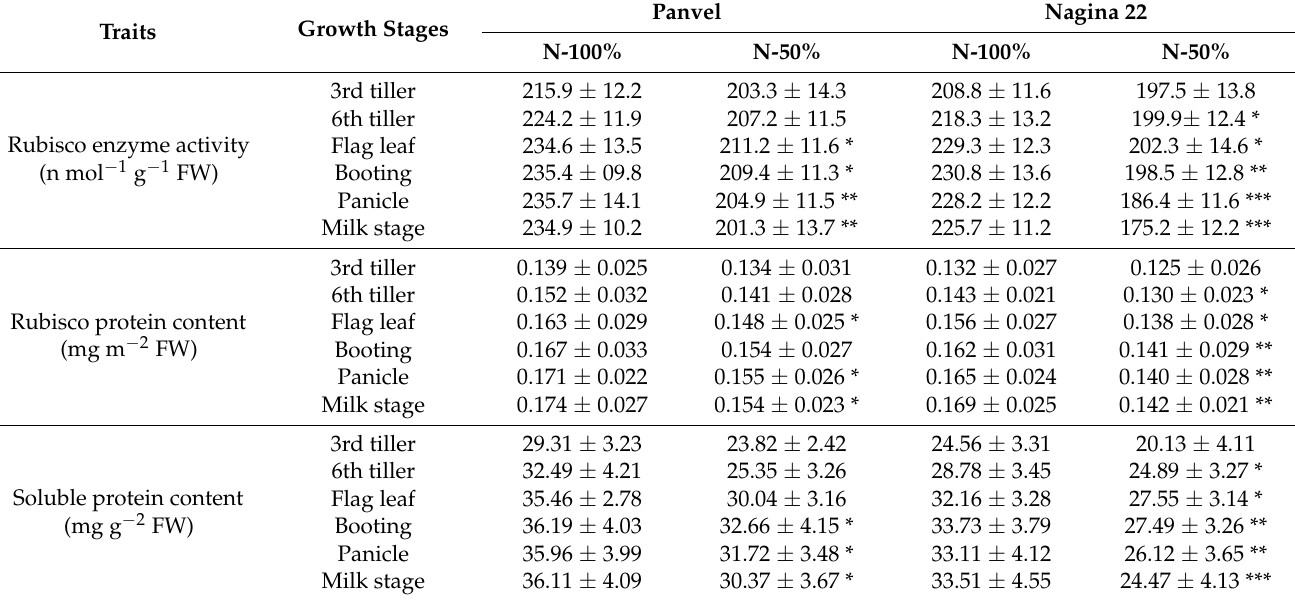
Table 2. Rubisco enzyme activity and Rubisco and soluble protein content in rice leaves of Panvel and Nagina 22 at six growth stages under optimum and low N